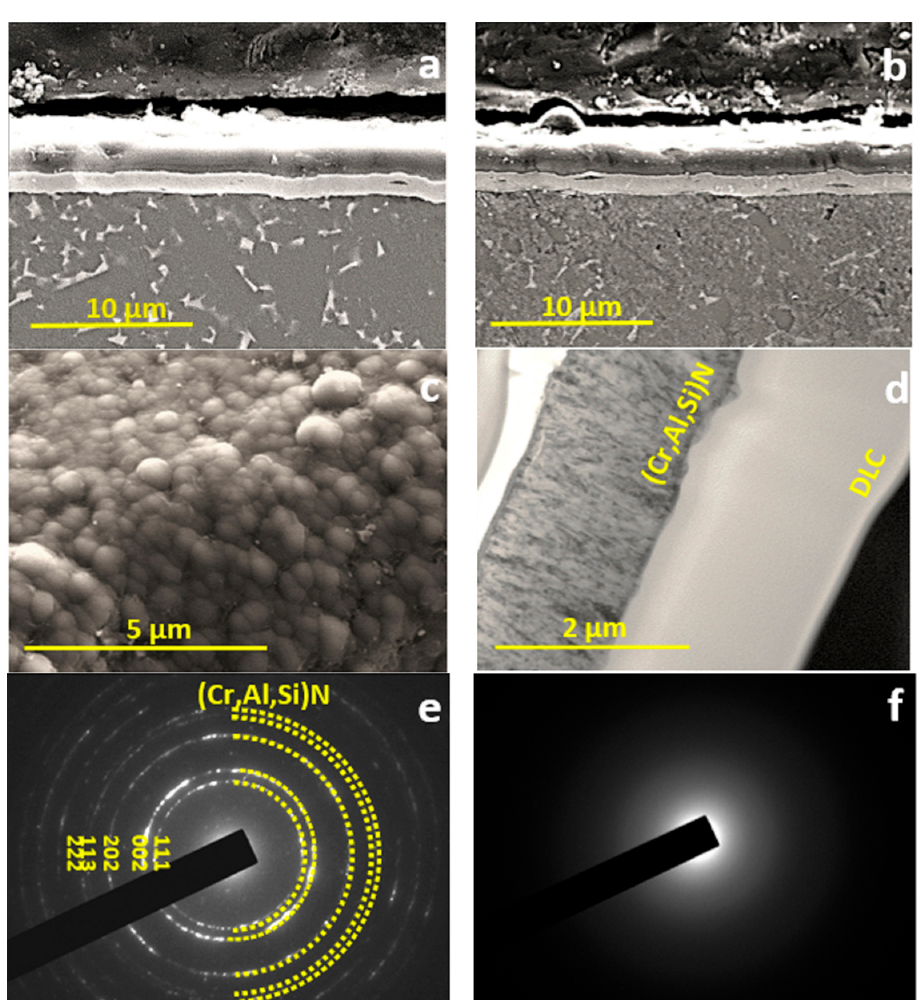
Figure 12. Microstructure of ceramic specimens with DLC coatings: ( a ) SEM image of a thin section of an experimental specimen 80% (90 α 10 β ) + 20% TiN ceramics with DLC coating; ( b ) SEM image of a thin section of commercial ceramics specimen with DLC coating; ( c ) SEM image of the DLC coating surface structure; ( d ) TEM image of the a two-layer DLC coating structure; ( e ) SAED of the (CrAlSi)N sublayer; and ( f ) SAED of the functional DLC layer.